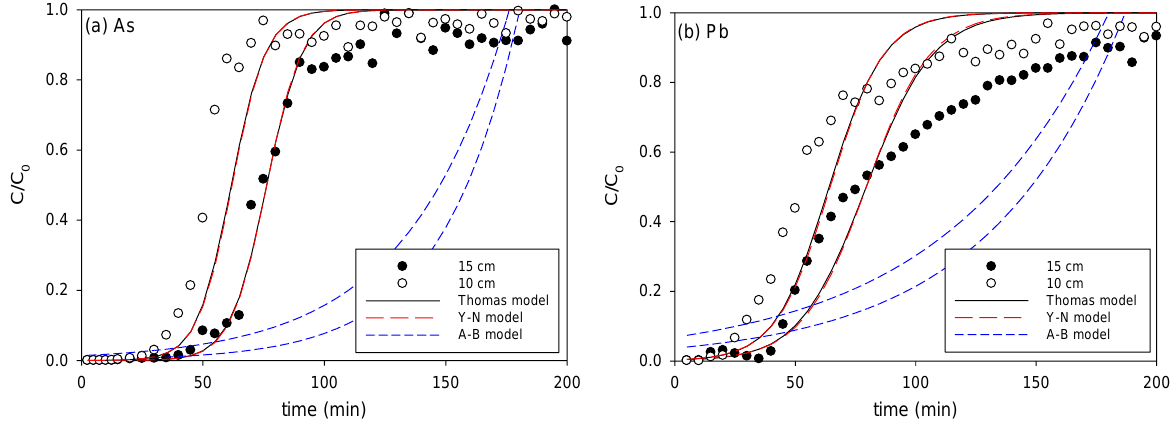
Figure 11. The effect of bed height on ( a ) As and ( b ) Pb adsorption breakthrough curves.